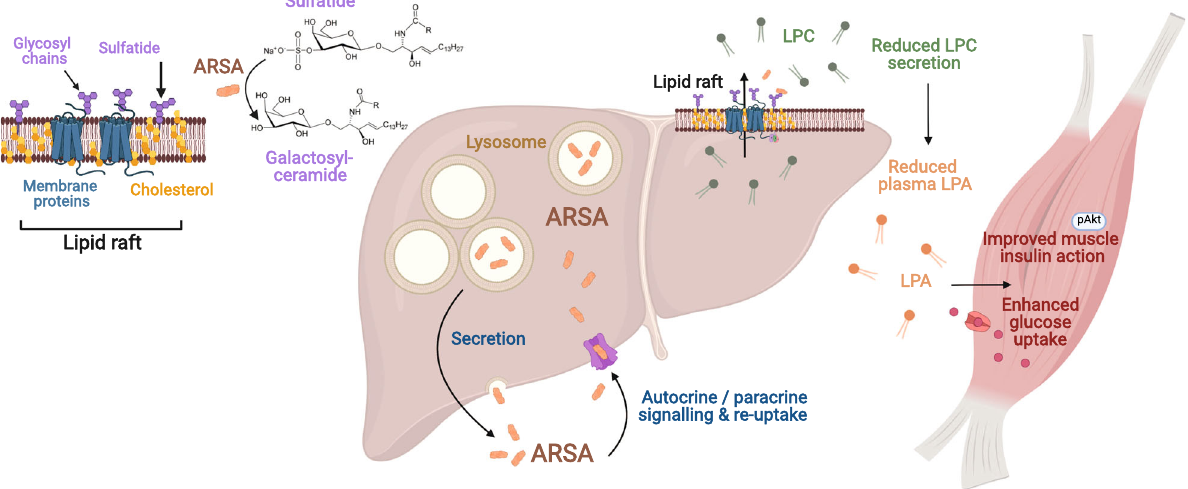
Fig. 8 Graphic summary highlighting the impact of liver-derived ARSA on sulfatide and lysophospholipid metabolism in liver lipid rafts, the reduction in LPC and LPA levels in the blood, and how the reduced LPA relieves skeletal muscle insulin resistance. LPA lysophosphatidic acid, LPC lysophosphatidylcholine. Created with